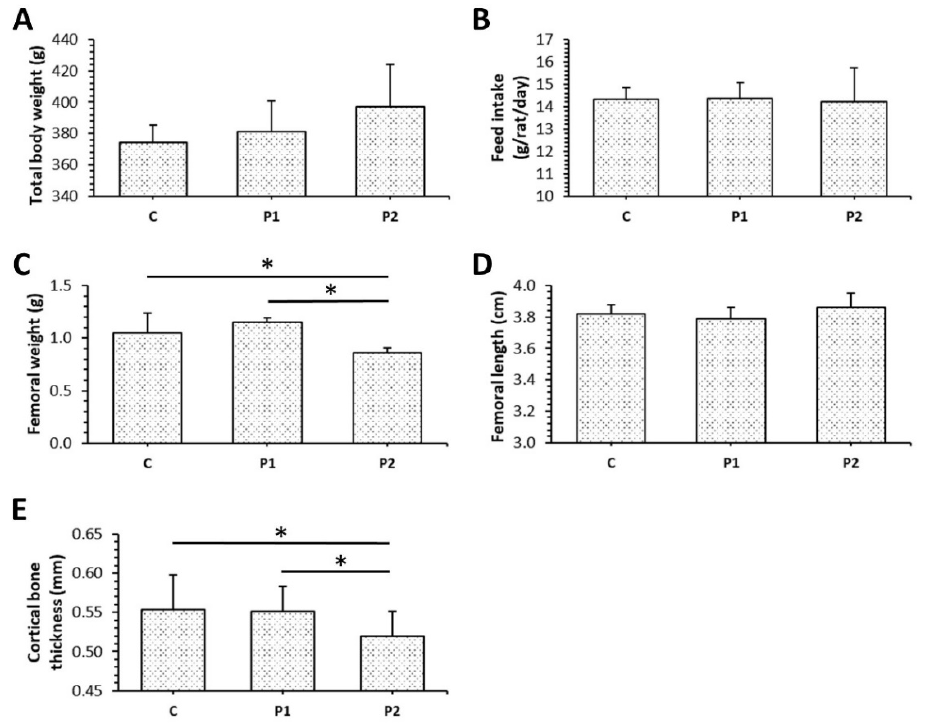
Figure 1. Total body weight ( A ), feed intake ( B ), femoral weight ( C ) and length ( D ), cortical bone thickness ( E ) in rats from C, P1, and P2 groups. * Significant differences ( p < 0.05). The levels of ALT did not vary between bee pollen supplemented groups and the control group. On the contrary, significantly lower values for AST were demonstrated in both P1 and P2 groups. In addition, ALP activity was significantly reduced in the P2 group when compared to the control (Figure 2A–C).